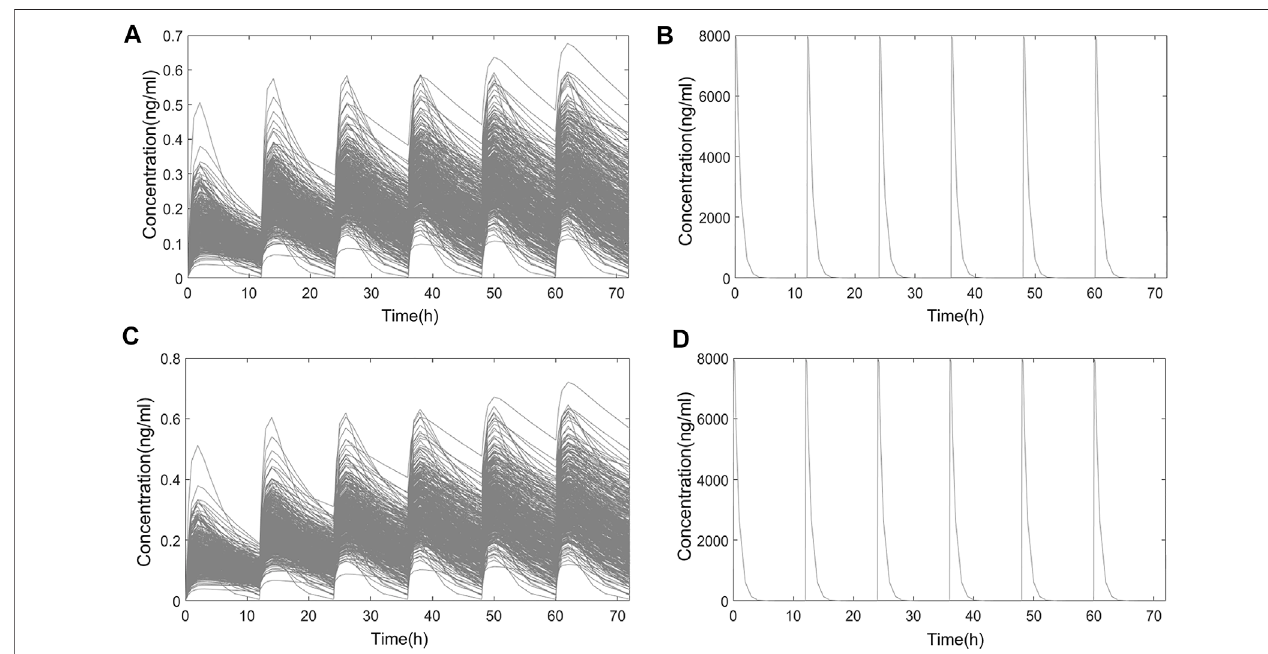
FIGURE 7 | Simulated PK curve of multidose administration. (A) Systemic PK in Chinese; (B) nasal PK in Chinese; (C) systemic PK in Americans; (D) nasal PK in Americans.